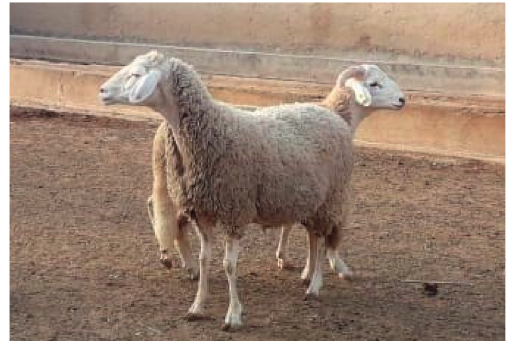
Figure 2: Ewe of Ouled-Djellal breed (18 months old) with its